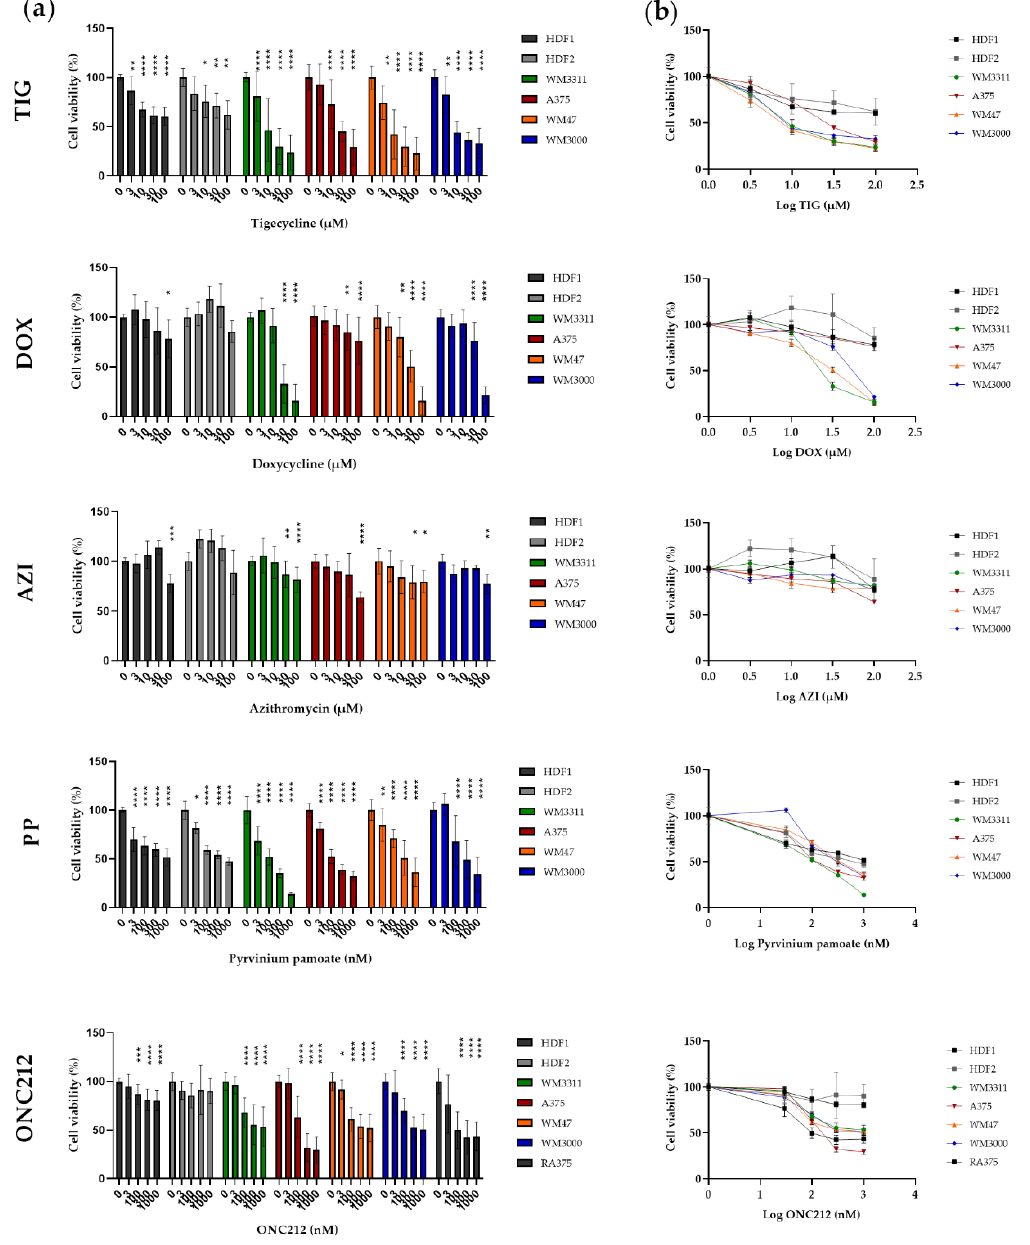
Figure 5. ( a ) E ff ect of TIG, DOX, AZI, PP and ONC212 on the growth of monolayer cultures of melanoma and HDF cell lines at the indicated concentrations for 72 h. ( b ) Dose response curve to generate IC50 values of drugs in melanoma cell lines and HDFs. Values are given as mean ± SD. Values are expressed relative to cell viability in vehicle-treated cells normalized to 100%. Values are given as mean ± SD. One-way ANOVA followed by Dunnett’s Multiple Comparison Test; * p ≤ 0.05; ** p ≤ 0.01; *** p ≤ 0.001; **** p ≤ 0.0001. Two to five independent experiments with four replicates were performed.